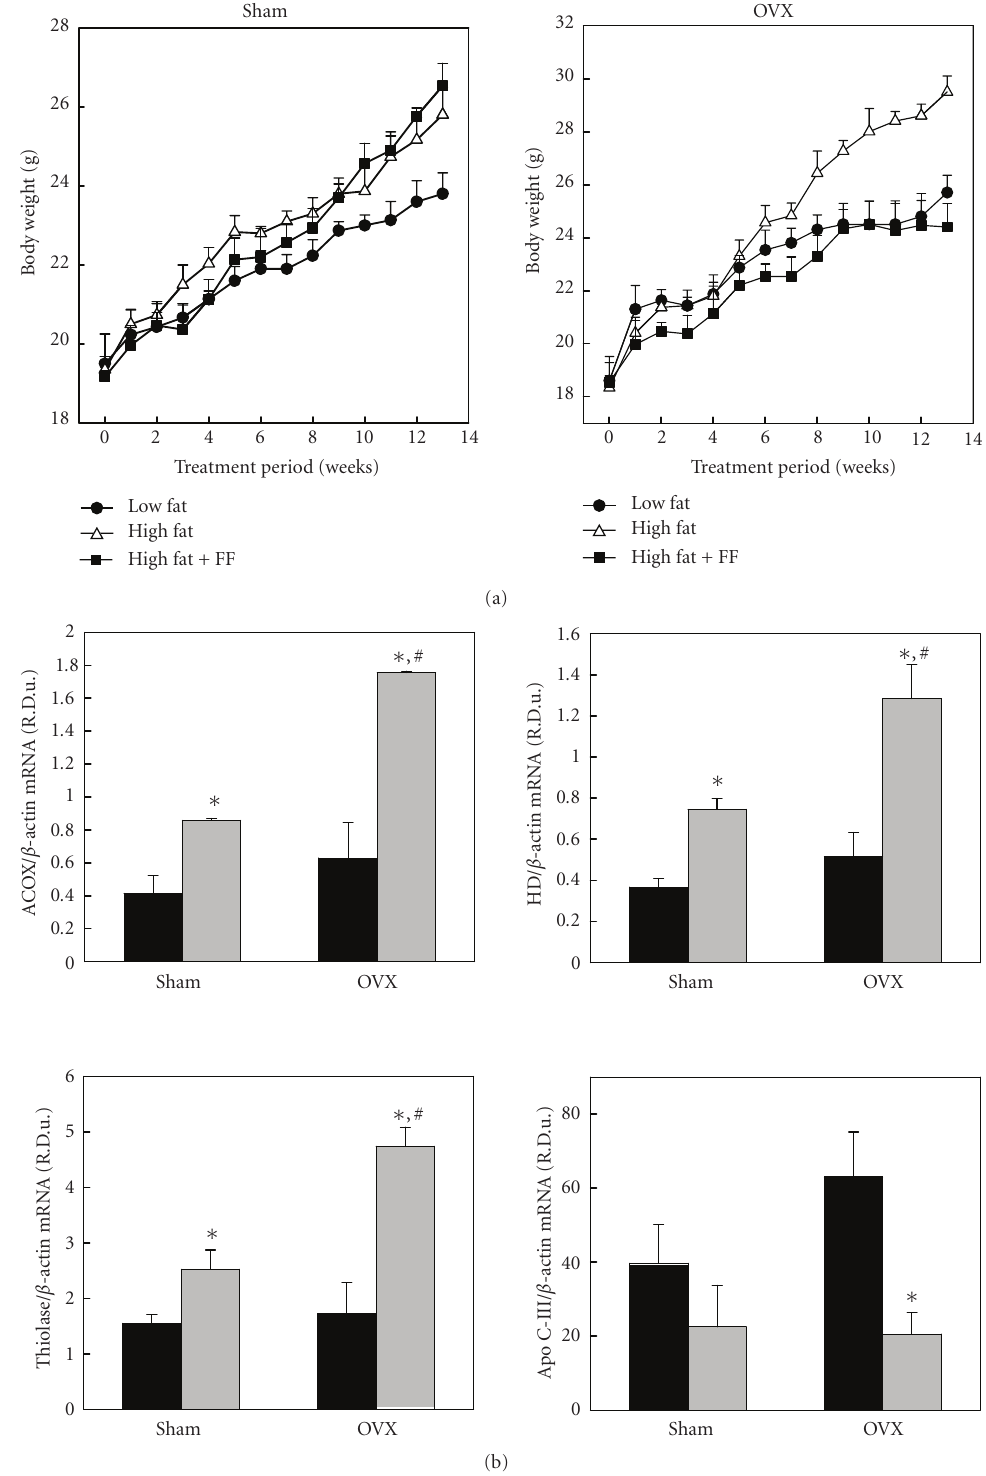
Figure 5: Di ff erential regulation of body weight gain (a) and PPAR α target gene expression (b) by fenofibrate depending on the presence of ovaries. Female sham-operated (Sham) and ovariectomized (OVX) mice received a low fat, high fat, or fenofibrate-supplemented (FF; 0.05% w/w) high fat diet for 13 weeks. Body weights at the end of the treatment period are significantly di ff erent not only when comparing the low fat group to either the high fat ( P < . 05) or high fat plus FF ( P < . 01) groups in female Sham mice, but also when comparing the high fat group to either the low fat ( P < . 01) or high fat plus FF ( P < . 005) groups in female OVX mice. ∗ : Significantly di ff erent versus the high fat